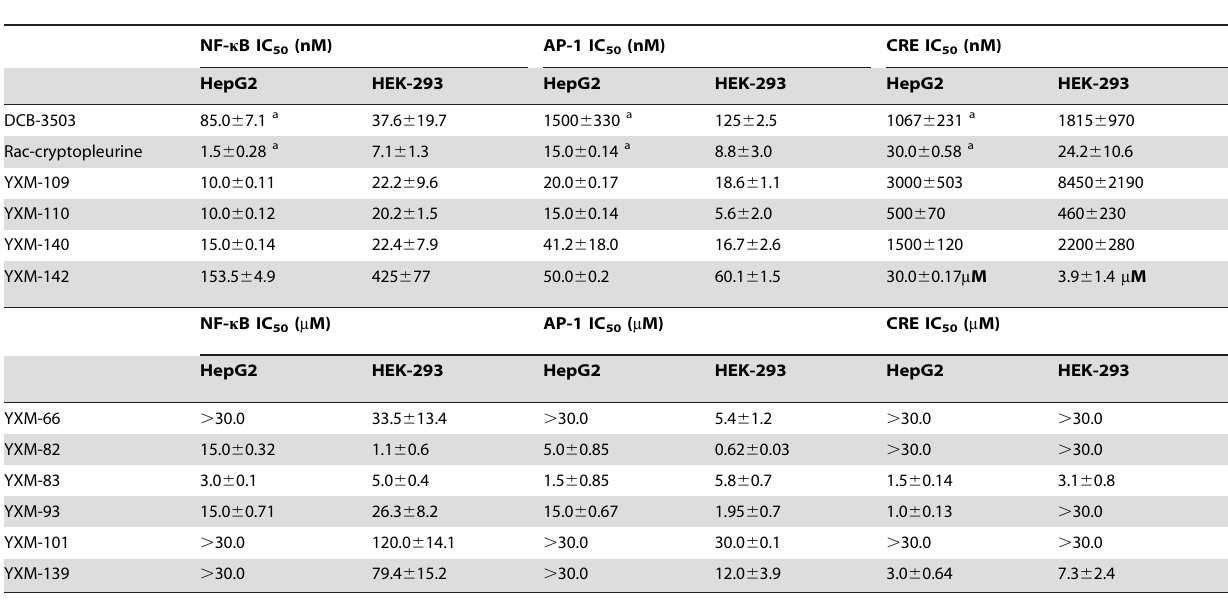
Table 2. The IC 50 of the inhibitory effect of tylophora alkaloids on NF- k B, AP-1, and CRE signalging pathways in HepG2 and HEK- 293 cells.